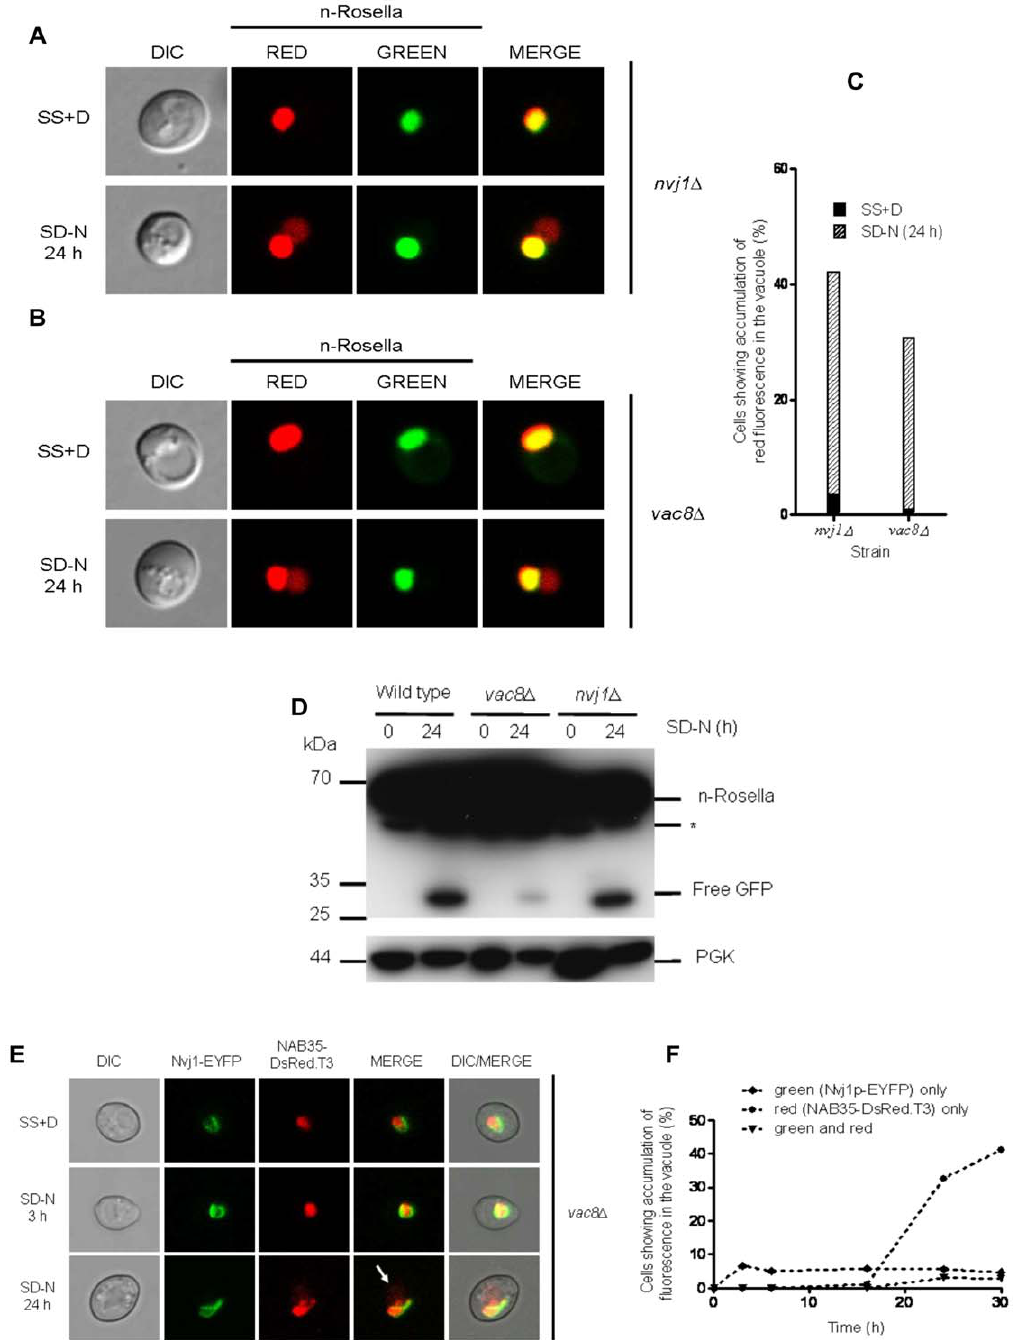
Figure 4. The inactivation of the NVJ1 and VAC8 genes required for PMN does not abrogate the delivery of n-Rosella to the vacuole. nvj1 D ( A ) and vac8 D ( B ) cells expressing n-Rosella were imaged under growing (SS + D) and nitrogen starvation (SD 2 N) conditions (24 hours after commencement of nitrogen starvation). ( C ) The percentage of nvj1 D and vac8 D cells showing accumulation of diffuse red fluorescence in the vacuole under growing (SS + D) and nitrogen starvation (SD-N) conditions (24 hours after commencement of nitrogen starvation). ( D ) Wild type, nvj1 D and vac8 D cells expressing n-Rosella were starved in SD( 2 N) medium for 0 and 24 hours, and the levels of the free GFP degradation product monitored by immunoblotting as described in Materials and Methods. Cytosolic PGK was detected as a loading control. *indicates the presumptive degradation product of n-Rosella lacking the NAB35 nuclear targeting signal. ( E ) vac8 D cells co-expressing the two nuclear reporters, Nvj1-EYFP and NAB35- DsRed.T3 were imaged under growing (SS + D) and nitrogen starvation (SD 2 N) conditions (3 and 24 hours after commencement of nitrogen starvation), respectively. The accumulation of NAB35-DsRed.T3-derived fluorescence (diffuse red fluorescence) is indicated by white arrow. ( F ) Percentage of vac8 D cells showing accumulation of fluorescence in the vacuole over time: ¤ green (Nvj1p-EYFP) only; . green and red.